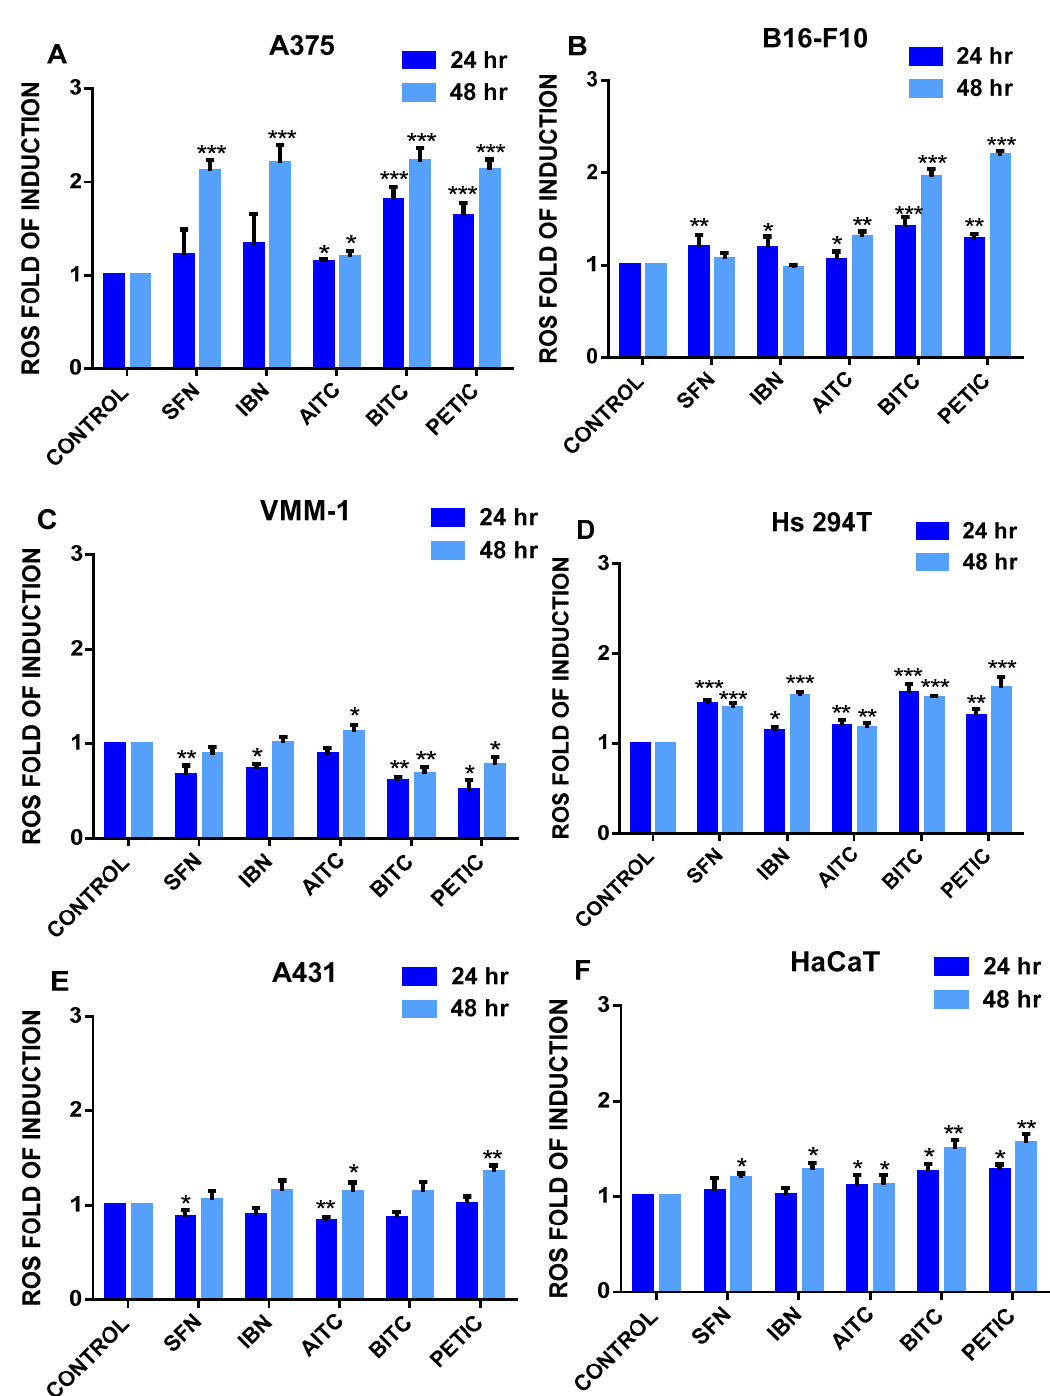
Figure 2. The effect of various ITCs on ROS levels in an in vitro model of MM. Cells were exposed to 10 µ M of each ITC, for 24 and 48 h, and monitored by means of flow cytometry. Results were quantitated as ROS fold induction levels for ( A ) A375, ( B ) B16F-10, ( C ) VMM1, ( D ) Hs294T, ( E ) A431 and ( F ) HaCaT cells. Data shown are means ± SD of three replicates from three independent experiments. * p < 0.05. ** p < 0.01, *** p < 0.001, when compared to untreated (control)